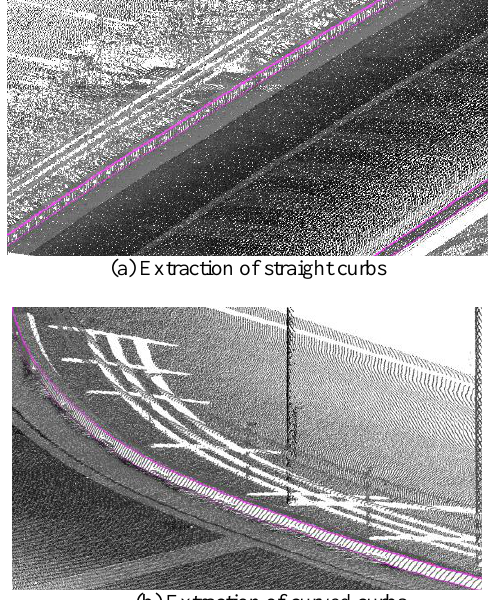
Figure 8. Closeups of straight and curved curbs